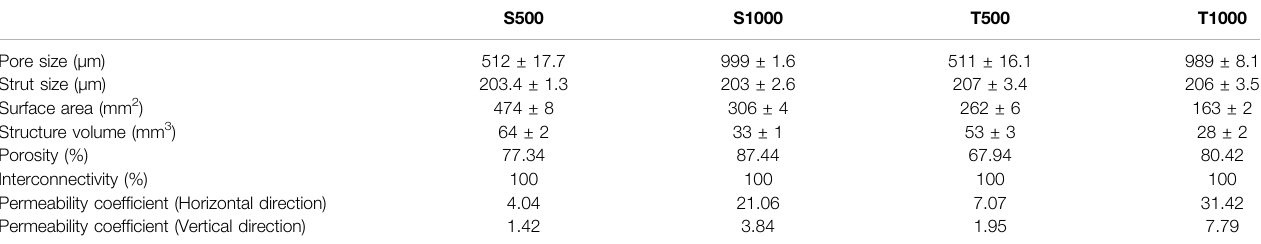
TABLE 1 | Characterisation of titanium scaffolds fabricated by SLM.